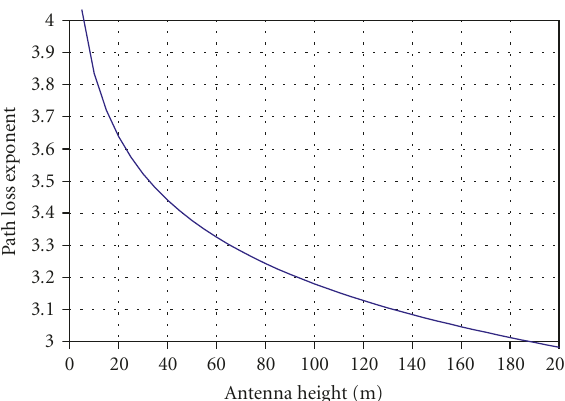
Figure 2: Path loss exponent as a function of antenna height.